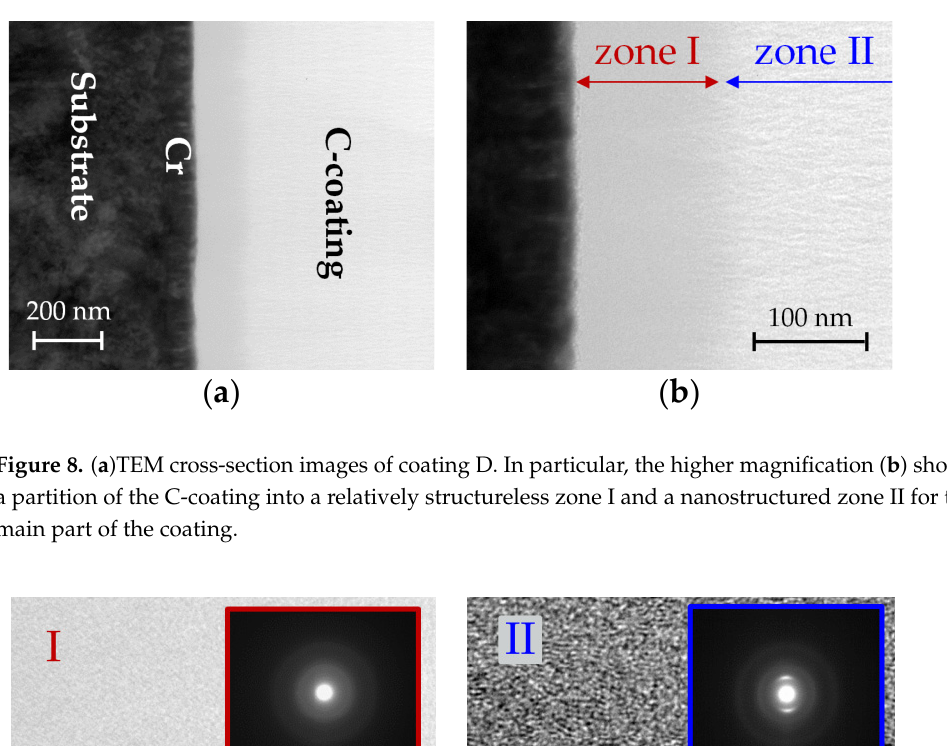
( b ) Figure 7. ( a ): in-plane Young’s modulus and hardness values measured by nanoindentation in coating D on a prepared cross-section. The values obtained by conventional, depth-resolved hardness measurement are included for illustration (grey symbols). The Young’s modulus value as measured by LAwave is added for comparison (dashed green line). ( b ): schematic illustration of the measuring directions of the different measuring techniques. The results strongly support the hypothesis of existing anisotropy in the layer. For further validation, the structure cross-section was investigated by TEM using high-reso- lution imaging and selected area diffraction (SAD) imaging. Figure 8 shows the setup of coating D, comprising an approximately 100 nm-thick Cr